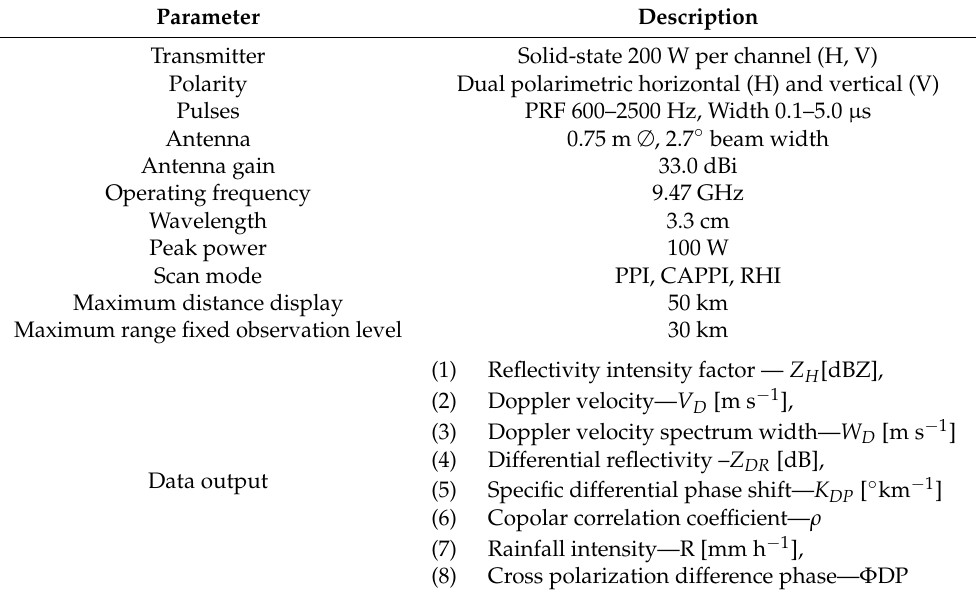
Table 1. Radar specification used in the study